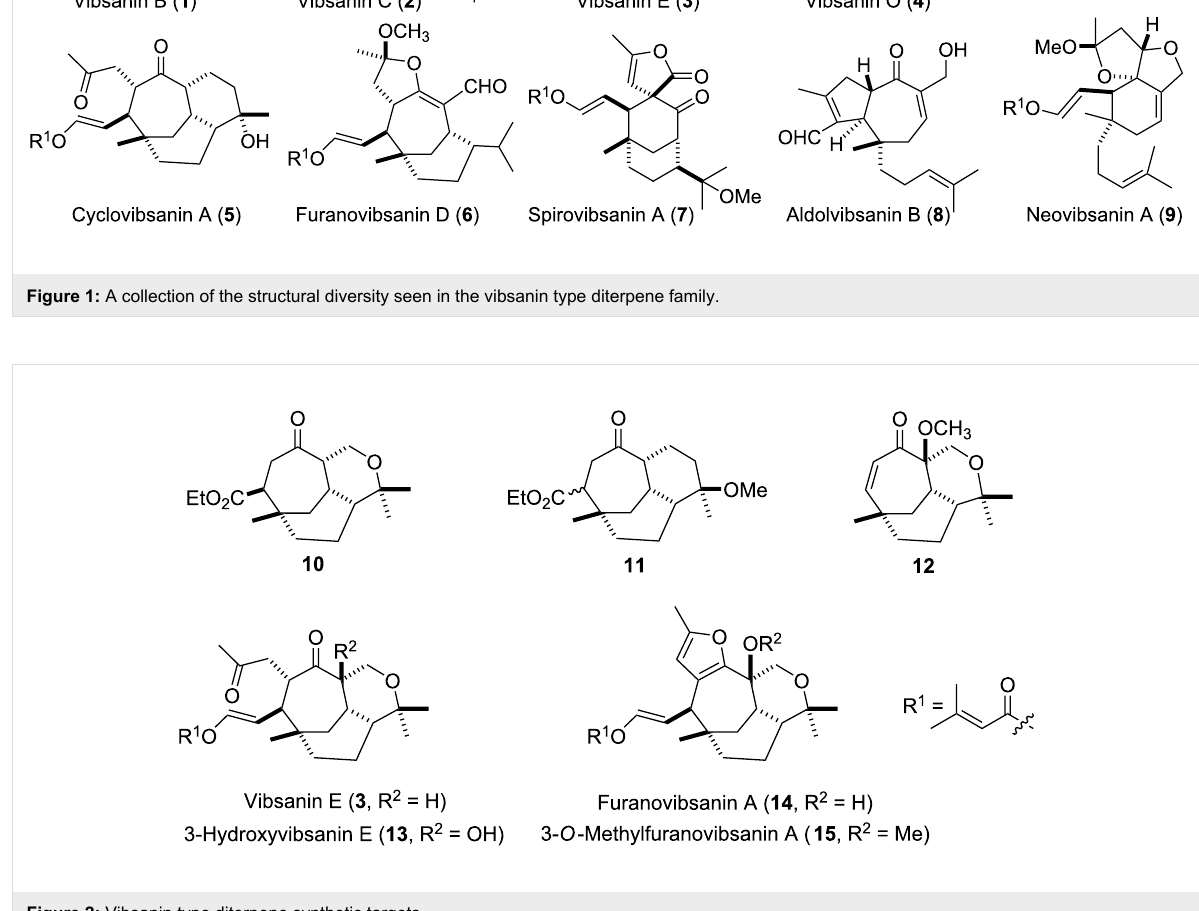
Figure 2: Vibsanin type diterpene synthetic